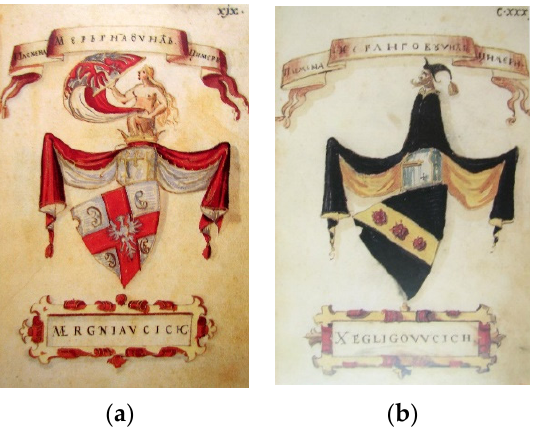
Figure 3. ( a ) The CoA of the Mrgniavcievich family from the Korenich-Neorich armorial. ( b ) The CoA of the Zhegligovich family from the Korenich-Neorich armorial.